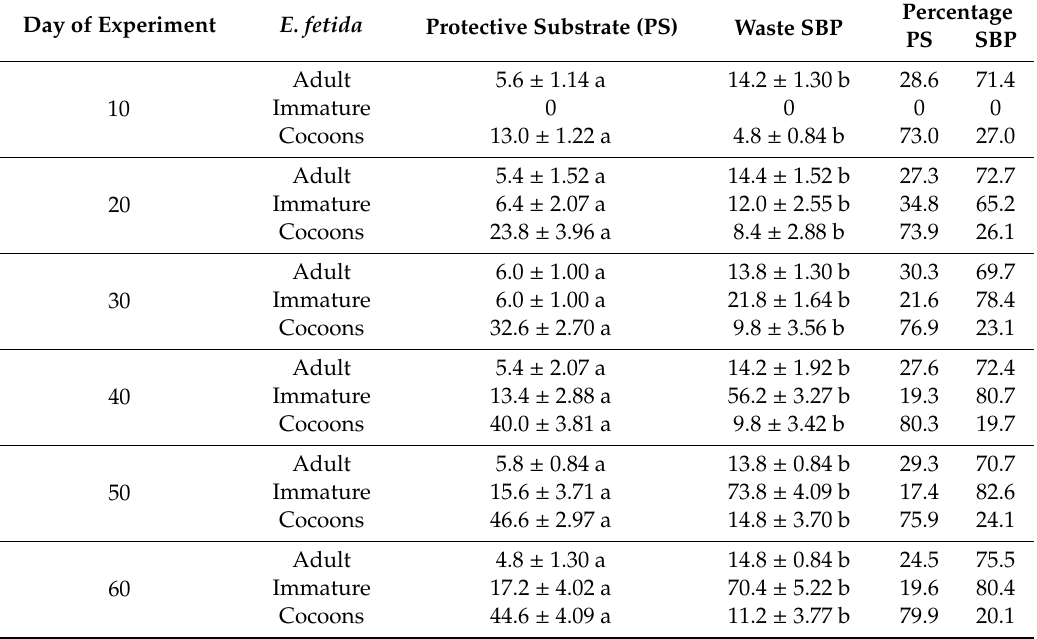
Table 2. Distribution of the number of mature individuals, immature individuals and cocoons of E. fetida in the protective substrate (PS) and the sugar beet pulp (SBP) waste mass during the inspection of the earthworm population